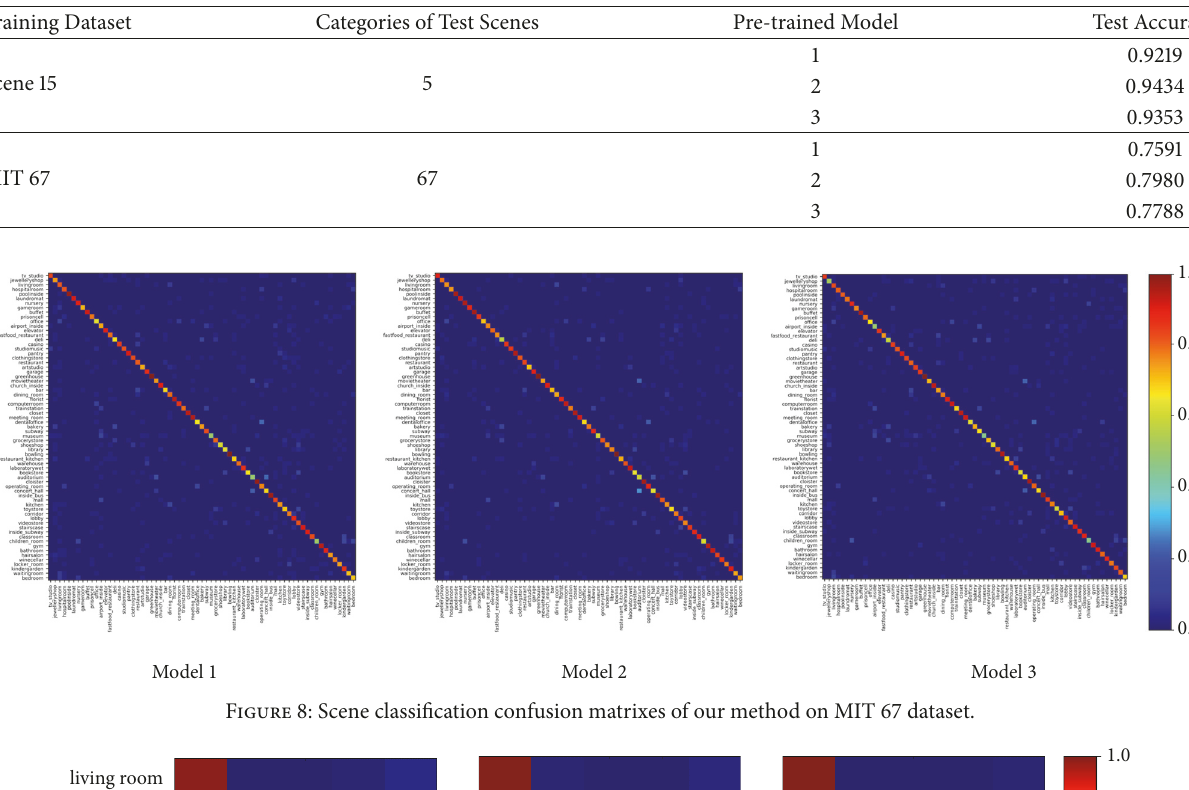
Table 8: Test results on SUN 397 dataset with diverse trained models.